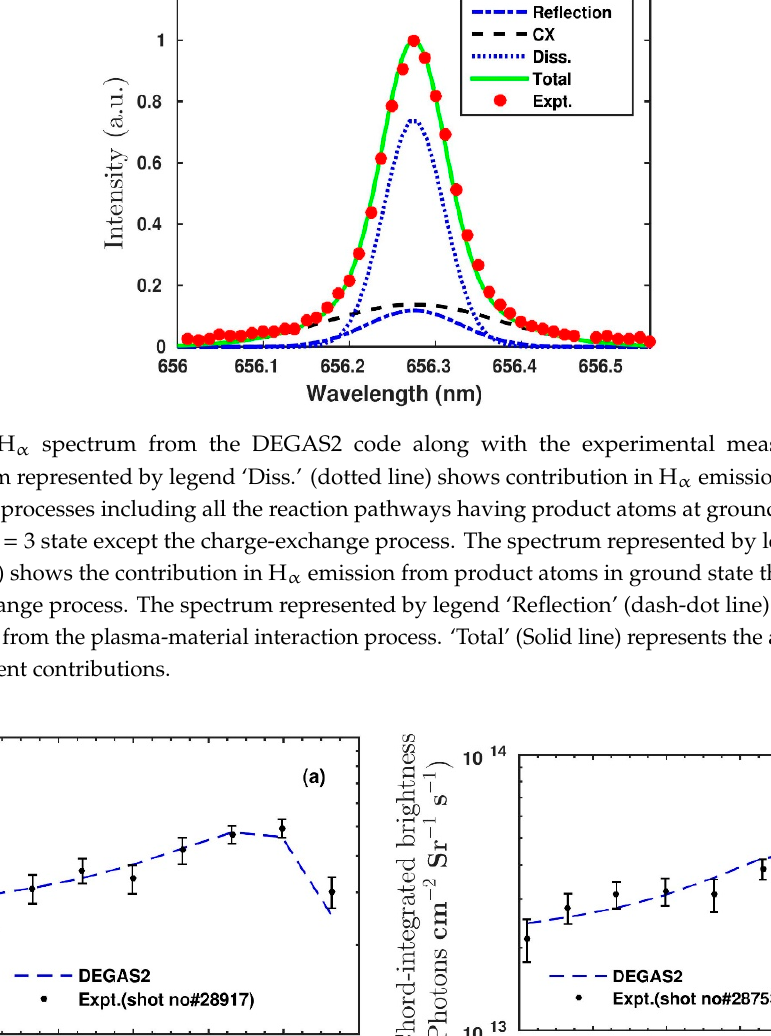
Figure 5 . (a) Simulated neutral H density (solid curve) for shot #28917 having n e =1.46 × 10 13 cm -3 and (dashed curve) for shot #28753 having n e = 2.10 × 10 13 cm -3 . (b) Simulated neutral H density for plasma having electron density 2.10 × 10 13 cm -3 when the core electron temperatures are taken to be 440 (solid curve) and 380 eV (dashed curve) for shot #28917 and shot #28753, respectively. The obtained simulated neutral hydrogen density profiles of two discharges are plotted in Figure 5a. It is found that neutral hydrogen is penetrated less inside the core plasma in case of relatively high-density discharge compared to the discharges having relatively low density. The neutral H density at ρ = 0.2 is ~2.9 × 10 7 cm -3 and ~8.1 × 10 7 cm -3 for high- and low-density discharges, respectively, although both the discharges have similar peak values of neutral density at the plasma edge. However, one can see that the two discharges have different core temperatures (T e,0 = 380 and 440 eV for shot #28753 and #28917, respectively). Then, a study is done to find the variation of simulated neutral hydrogen density profile with the variation of core electron temperature for the same electron density. This is done for the discharge having line-averaged electron density of 2.10 × 10 13 cm -3 . The radial profiles of the simulated neutral hydrogen densities for different core temperatures are plotted in Figure 5b. It is observed that the radial profile of neutral hydrogen density is not sensitive to the change in core electron temperature. It is due to the fact that almost all the reaction rate coefficients (except Equations (XV) and (XVI) in Table 1) are constant beyond the electron temperature ~50 eV. Then it can be said that the penetration of neutral particle mainly depends on the electron density as the plasma having higher density shows lesser neutral penetration.